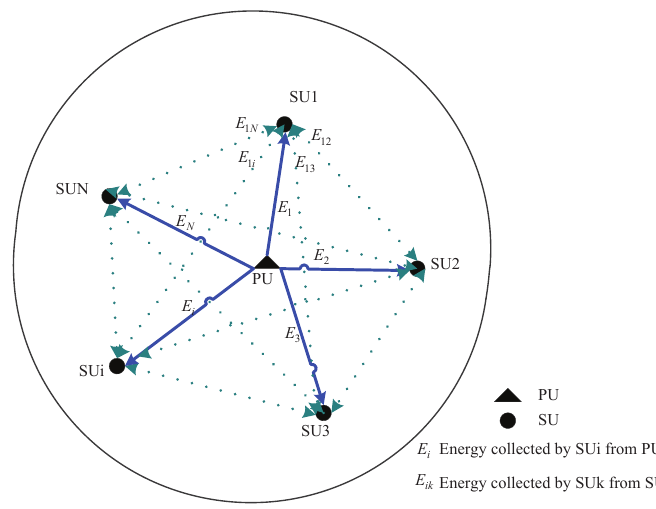
Figure 2. The relation between primary user (PU) source signal and secondary users